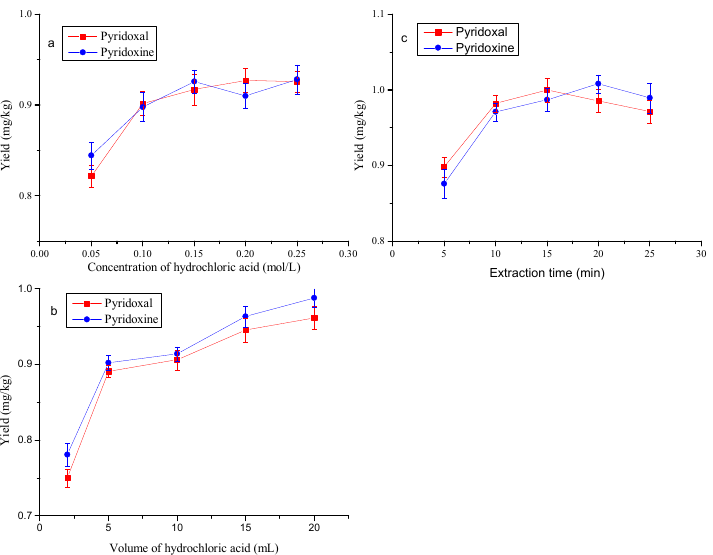
Figure 6. Effects of concentration and volume of hydrochloric acid and extraction time on the yields. ( a ) Extraction with 10 mL for 15 min; ( b ) extraction with 0.15 mol/L for 15 min; ( c ) hydrochloric acid concentration and volume were 0.15 mol/L and 10 mL, respectively.